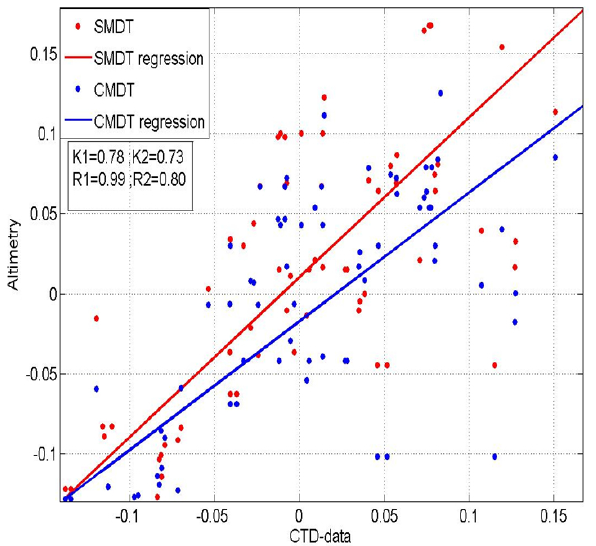
Fig. 9. Scattergram of mean amplitudes of drifting buoys and alti- metric velocities, reconstructed using SMDT and